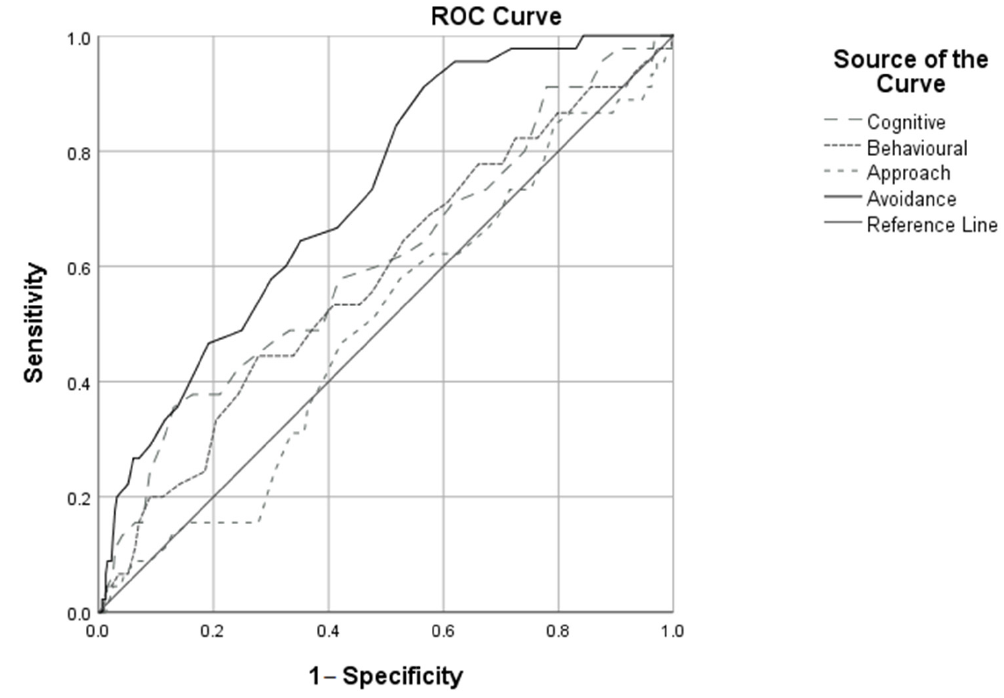
Figure 1. ROC curve for the CRI-A dimensions predicting the presence of psychopathological dis- orders.